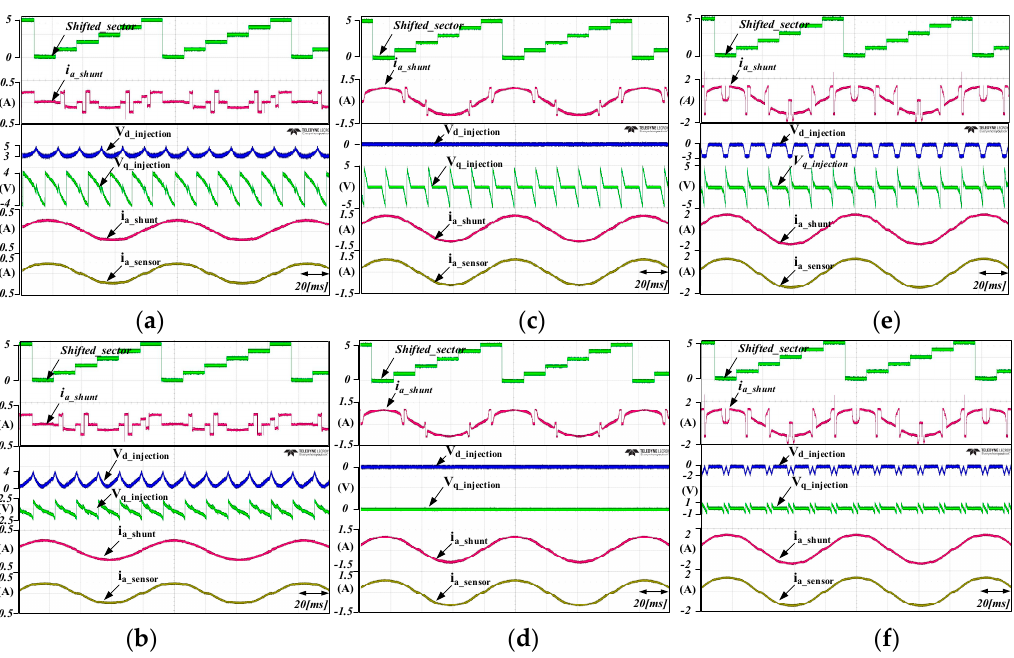
Figure 24. Comparison of the conventional and proposed methods at MI = 0.1, 0.4, and 0.6. ( a ) Conventional method at MI = 0.1; ( b ) proposed method at MI = 0.1; ( c ) conventional method at MI = 0.4; ( d ) proposed method at MI = 0.4; ( e ) conventional method at MI = 0.6; ( f ) proposed method at MI = 0.6.